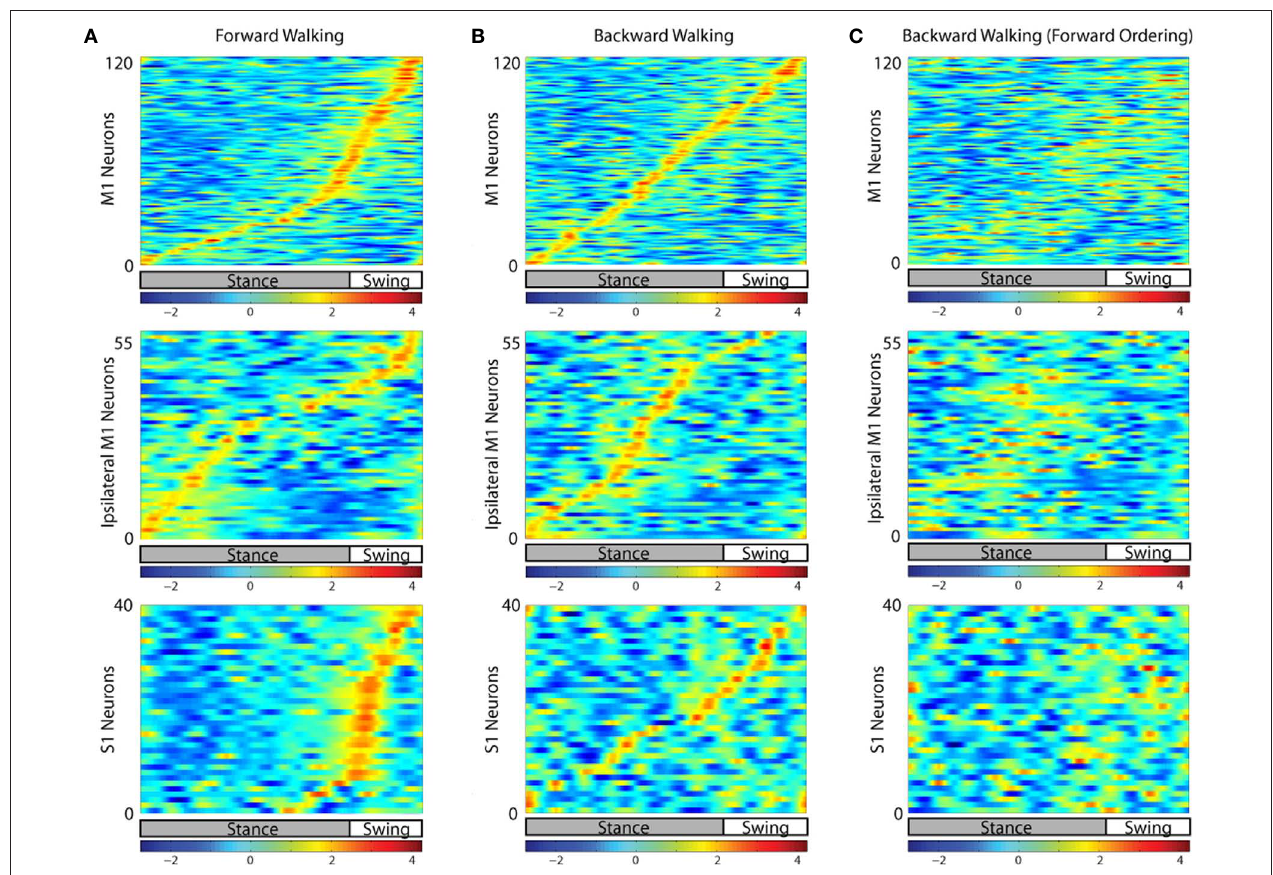
activity. The average durations of the stance and swing phases of the step cycle are shown below each plot. Swing was slightly longer during backwards walking. (A) Average neural activity during forward walking, ordered via peak activity during forward walking. (B) Average neural activity during backward walking, ordered via peak activity during backward walking. (C) Average neural activity during backward walking, ordered via peak activity during forward walking [i.e. neurons are ordered the same way in (A) and (C)